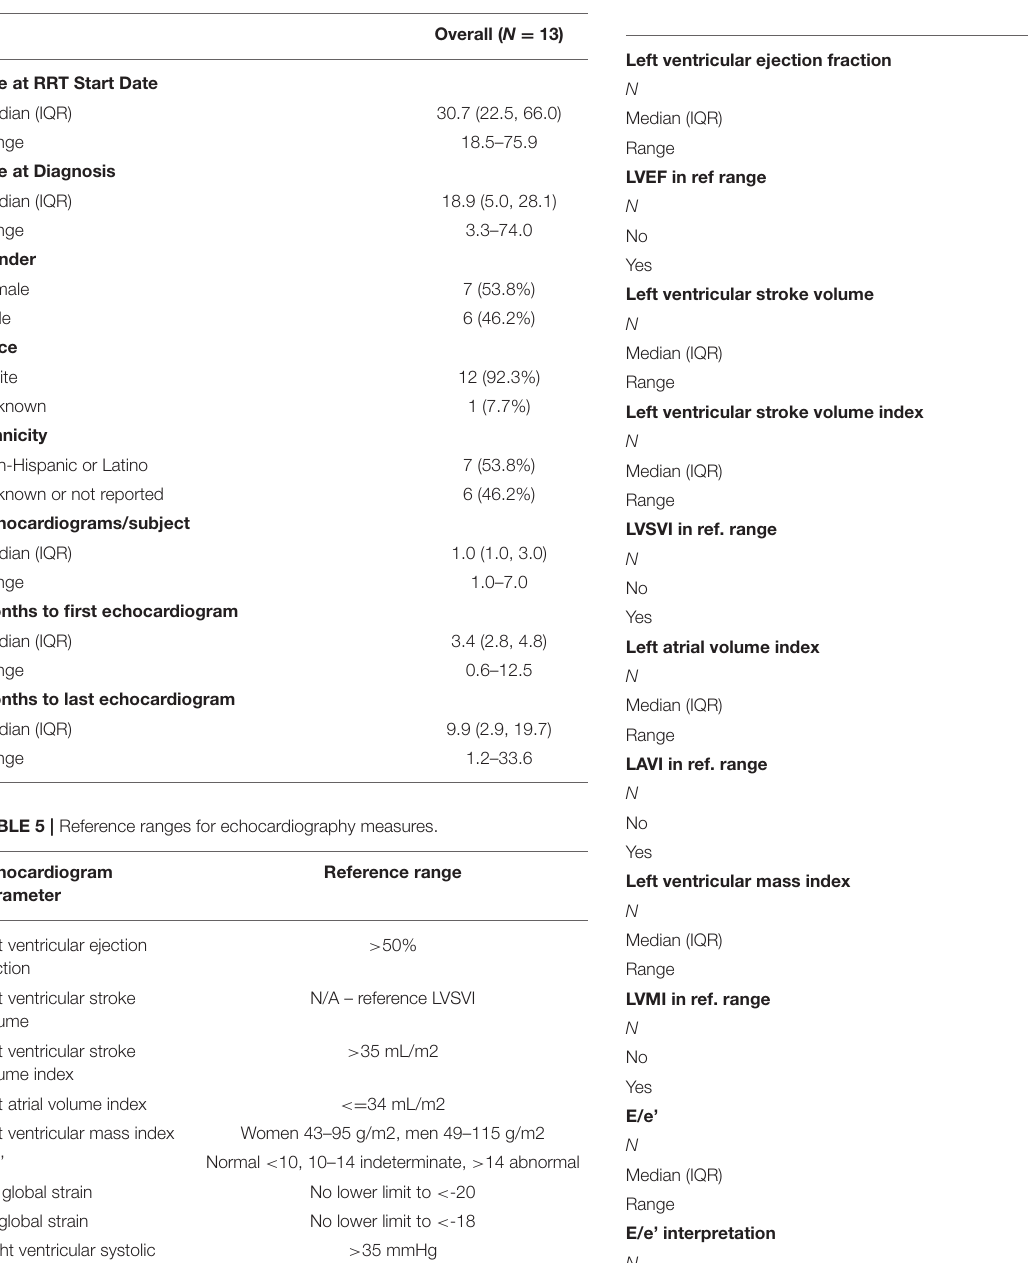
TABLE 6 | Descriptive echocardiographic data for PH1 patients on